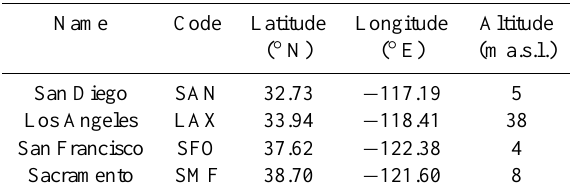
Table 2. Airport